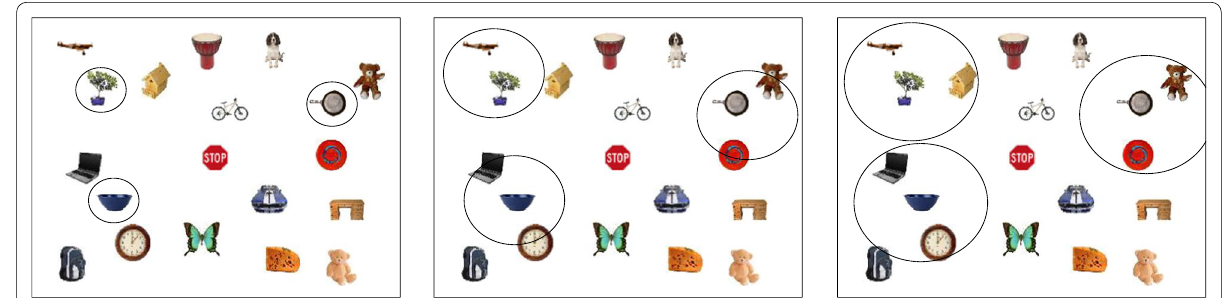
Fig. 8 Hypothetical 18-item display for a single-target search. To calculate FVF, circles are drawn around each fixation point, beginning with a radius of 1 degree (left panel). The radius of the circle is gradually increased until 50% of the items fall within one of the circles (right panel). Note The figure is not drawn to